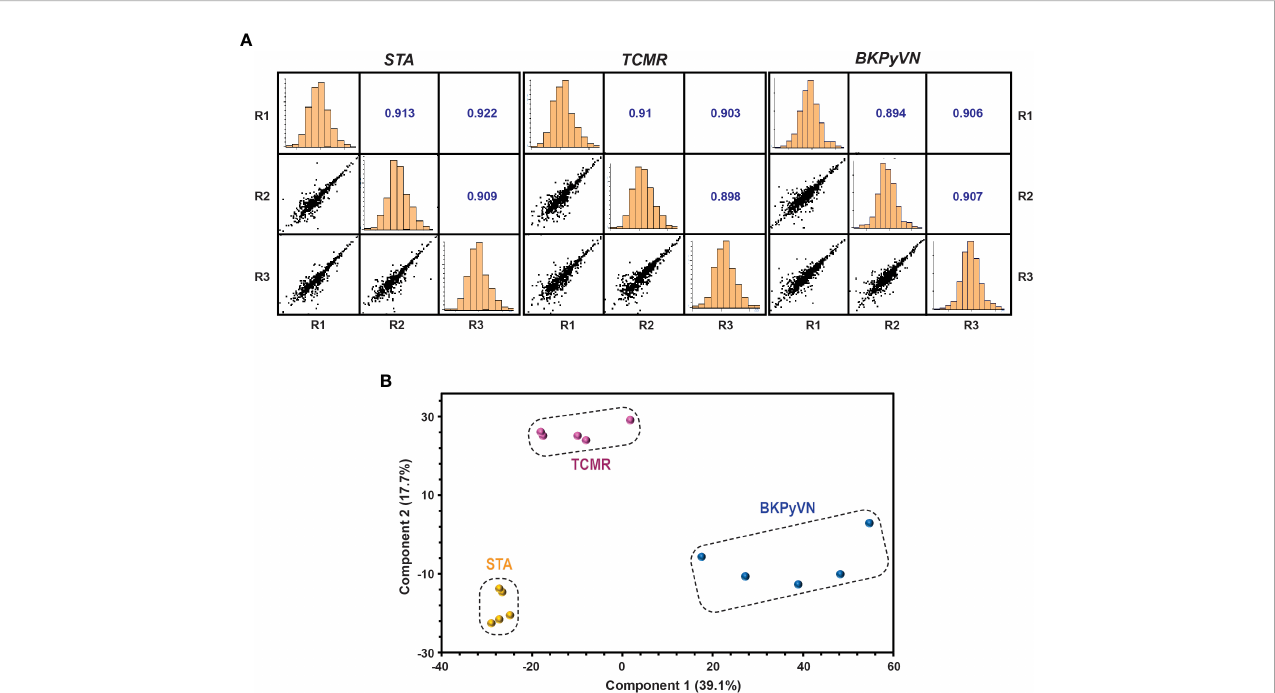
FIGURE 2 Quantitative proteomic pro fi ling of FFPE biopsies segregates different kidney transplant injuries. (A) Repeatability of label-free quantitative analysis. Correlations among 3 replicates for each sample were shown. The correlation coef fi cient shown in the fi gure represents the statistical relationship between every two replicates. The larger the value, the higher repeatability between the two replicates. (B) A PCA plot obtained by Perseus software demonstrated that the quanti fi ed FFPE biopsy proteins were able to segregate TCMR, BKPyVN and STA samples. The PC1 axis is the fi rst principal direction along which the samples show the largest variation. The PC2 axis is the second most important direction, and it is orthogonal to the PC1